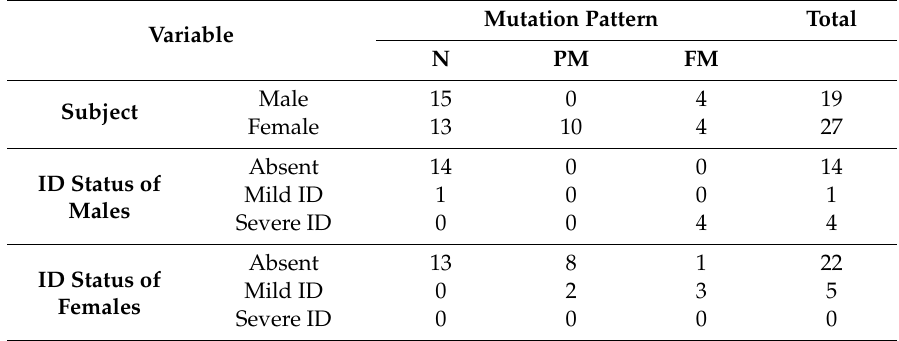
Table 1. Description of the study participants: FXS mutation, and Intellectual Disability status.